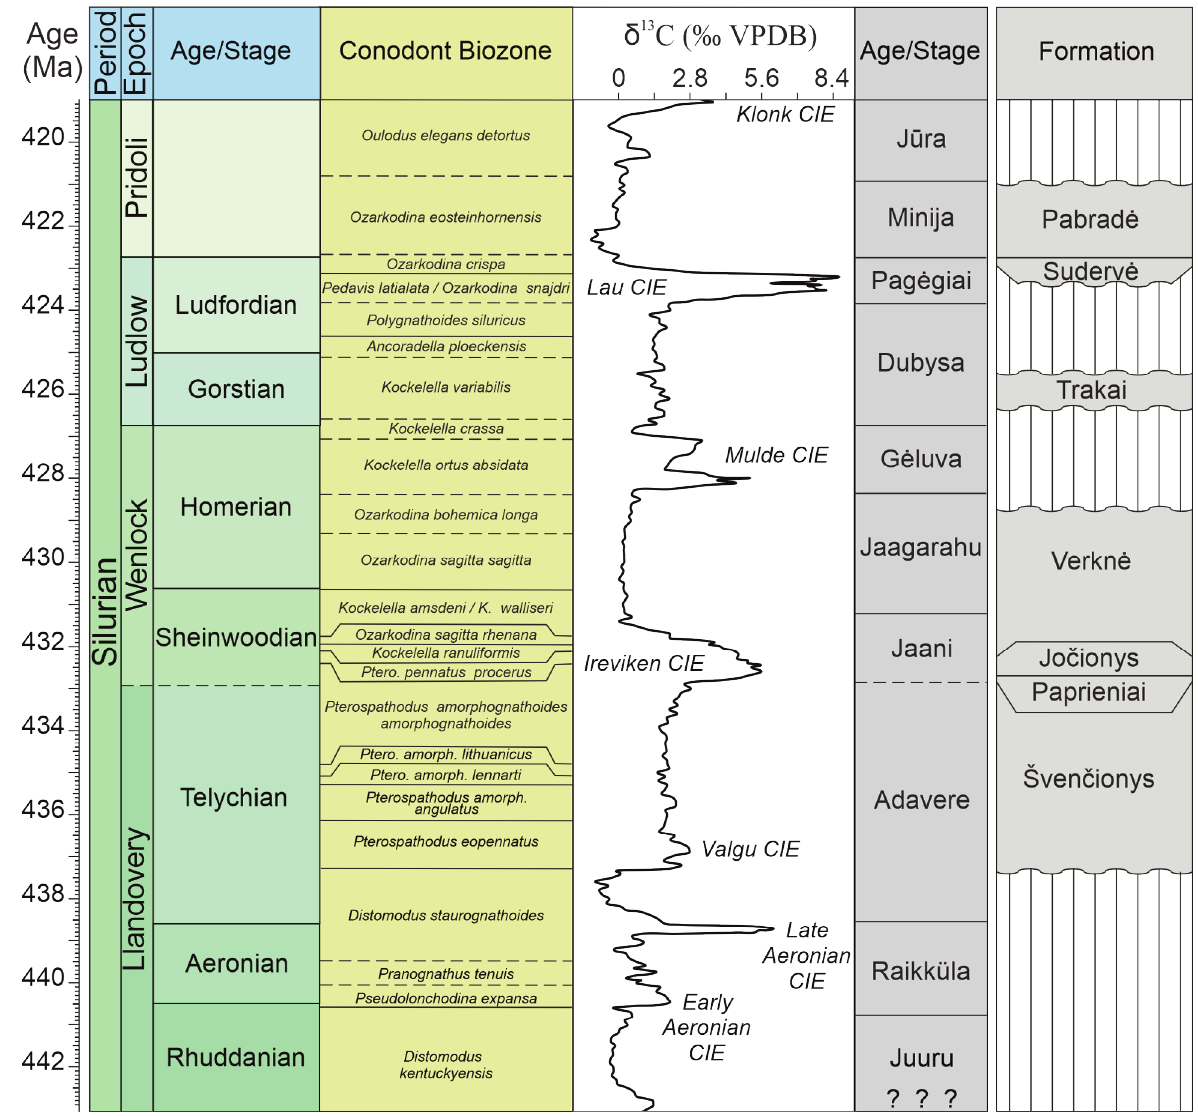
Fig. 3. Silurian time scale and conodont zonation (Melchin et al. 2020), Lithuanian regional stages and correlation of lithostratigraphic units of the Jo č ionys-299 borehole with the generalized δ 13 C